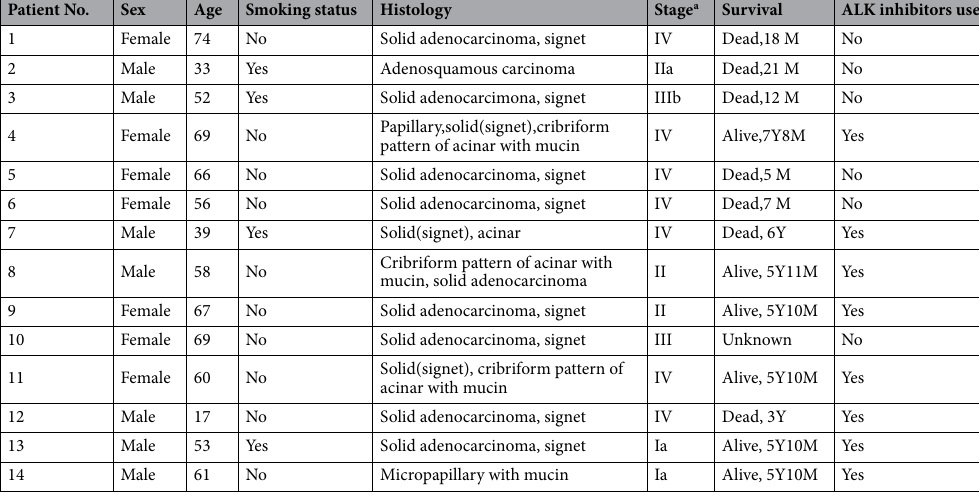
Table 4. The clinicopathologic findings of 14 patients with ALK rearrangement. a Clinical stage represents stage at initial diagnosis. Stage was determined according to WHO TNM classification of lung carcinomas in 2015.